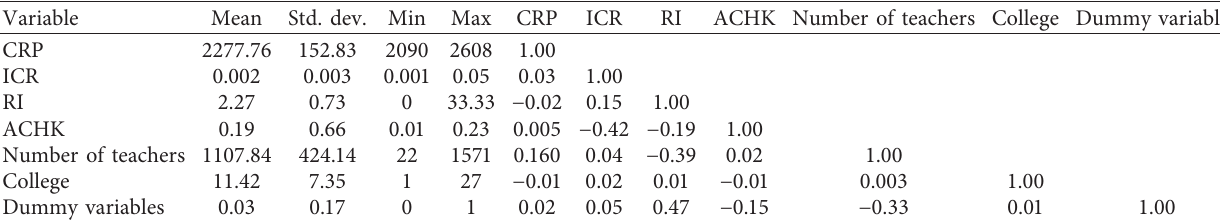
Table 1: Data description and correlation coefficient matrix.